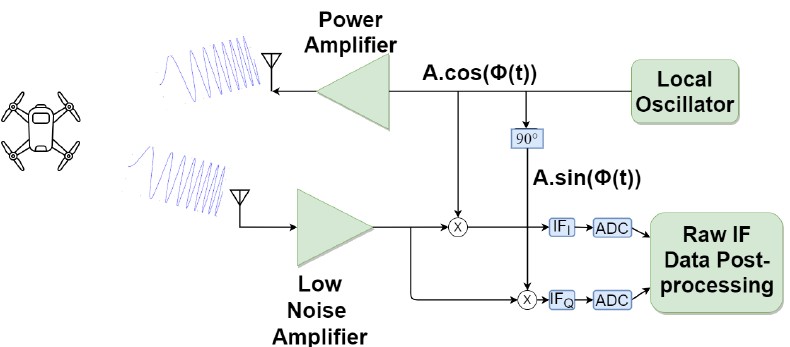
Figure 2. Radar front-end architecture with complex IF signal.